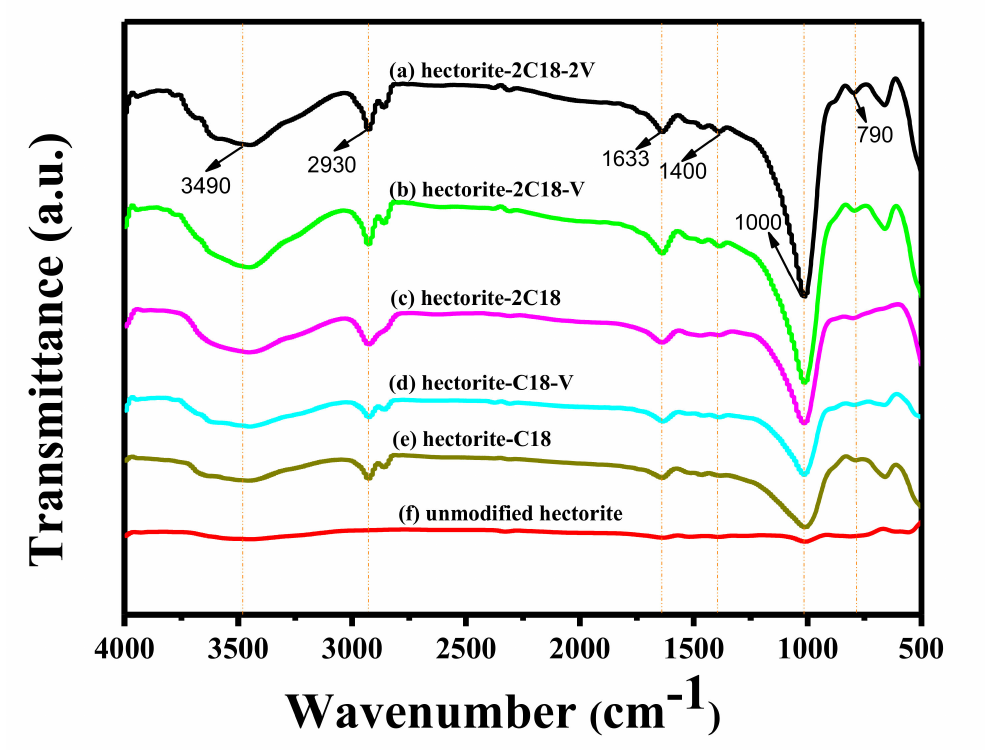
Figure 1. FTIR spectra of unmodified and modified hectorite prepared with different OTES/VTMS